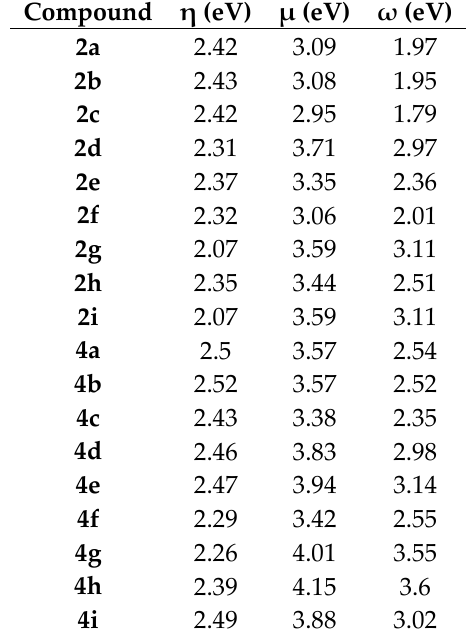
Table 2. Reactivity indices of compounds 2a – 2i and 4a – 4i .